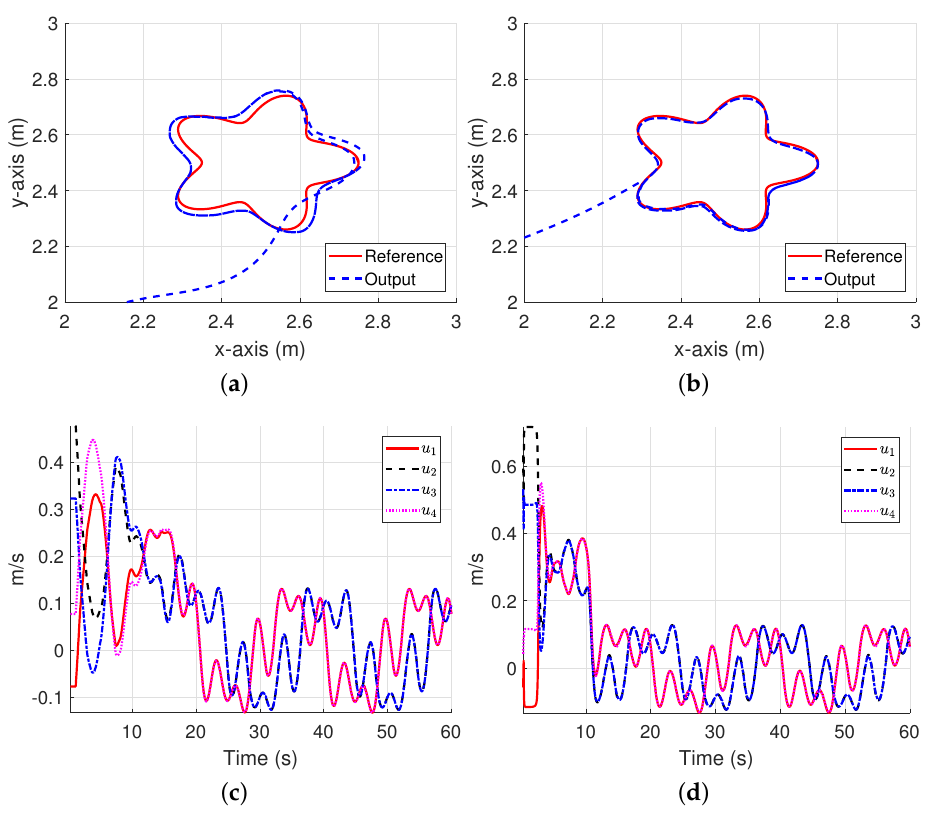
Figure 21. Experimental results for the rose curve trajectory. ( a ) Trajectory following for PID. ( b ) Trajectory following for EKF-SNPID. ( c ) Velocity control signal of PID. ( d ) Velocity control signal of EKF-SNPID.